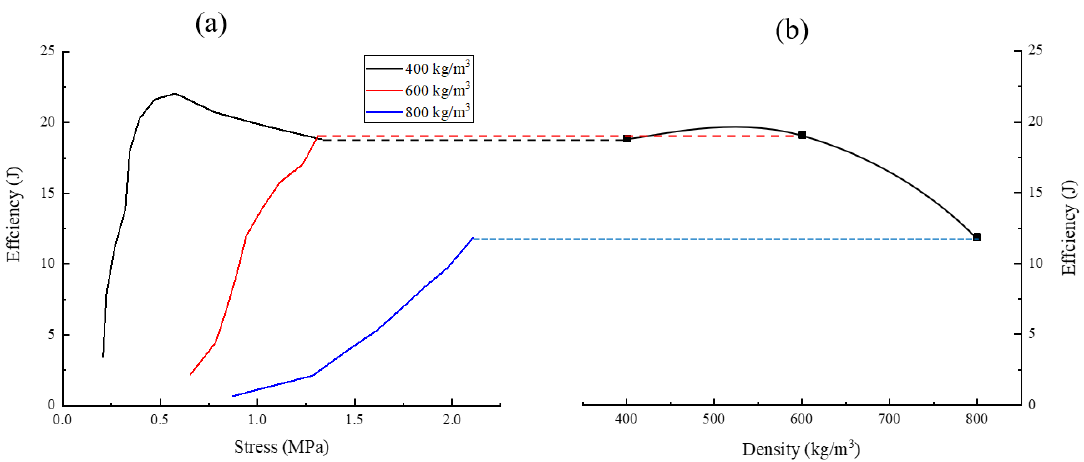
Figure 14. Energy-absorption diagram: ( a ) energy absorption efficiency–stress curve; ( b ) energy absorption efficiency–density curve.